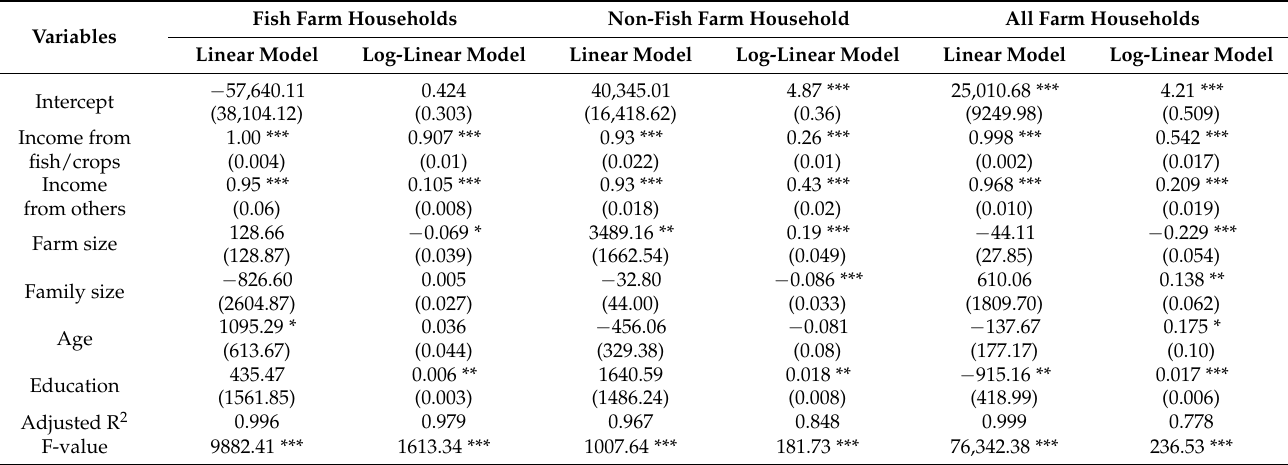
Table 2. Annual household income function of farm